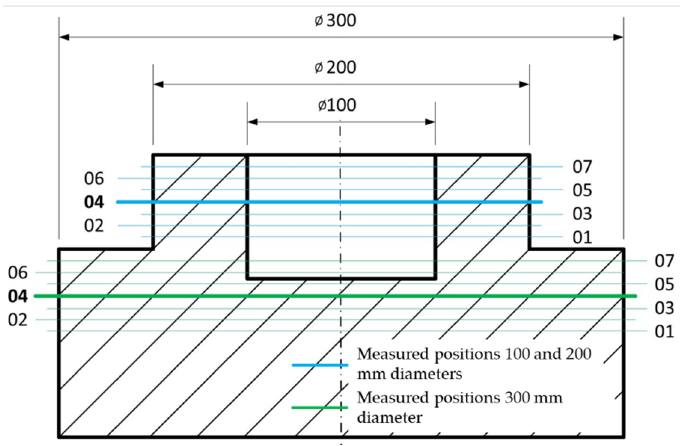
Figure 11. Diagram of the measured points on the 100, 200 and 300 mm diameters.